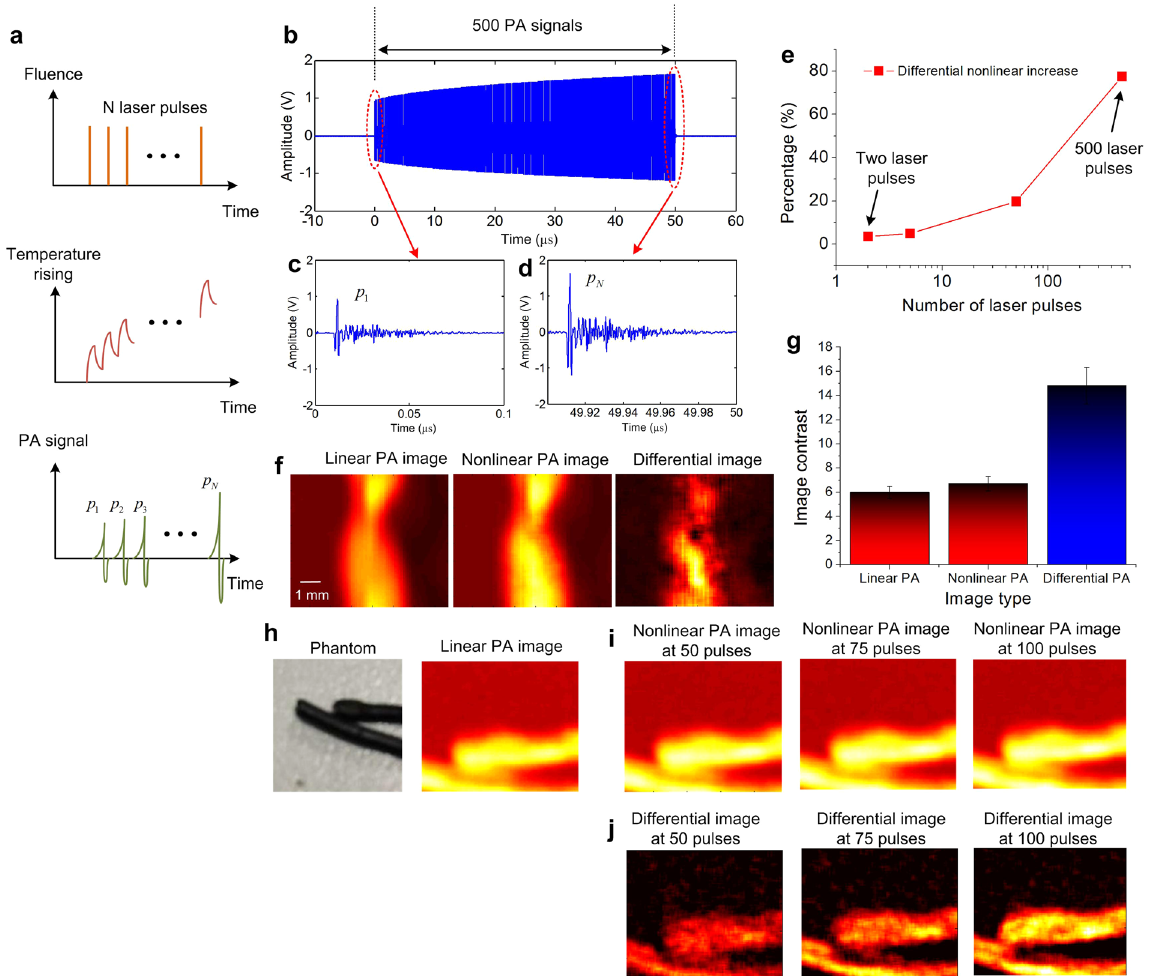
Figure 5. ( a ) The fluence pattern, temperature rising and PA signal diagram of the proposed LDPA technique by quasi-CW laser source. ( b ) A typical 500 PA signals, ( c ) the first linear PA signal, and ( d ) the last nonlinear PA signal. ( e ) The percentage of nonlinear increase versus the number of consecutive laser pulses. ( f ) The linear PA imaging, nonlinear PA imaging and differential imaging of a curved black wire, ( g ) and their quantitative comparison of imaging contrast. ( h ) The photograph of another two black wire phantom and its linear PA imaging. ( i ) The nonlinear PA imaging and ( j ) Differential imaging results at three different pulse numbers: 50, 75,